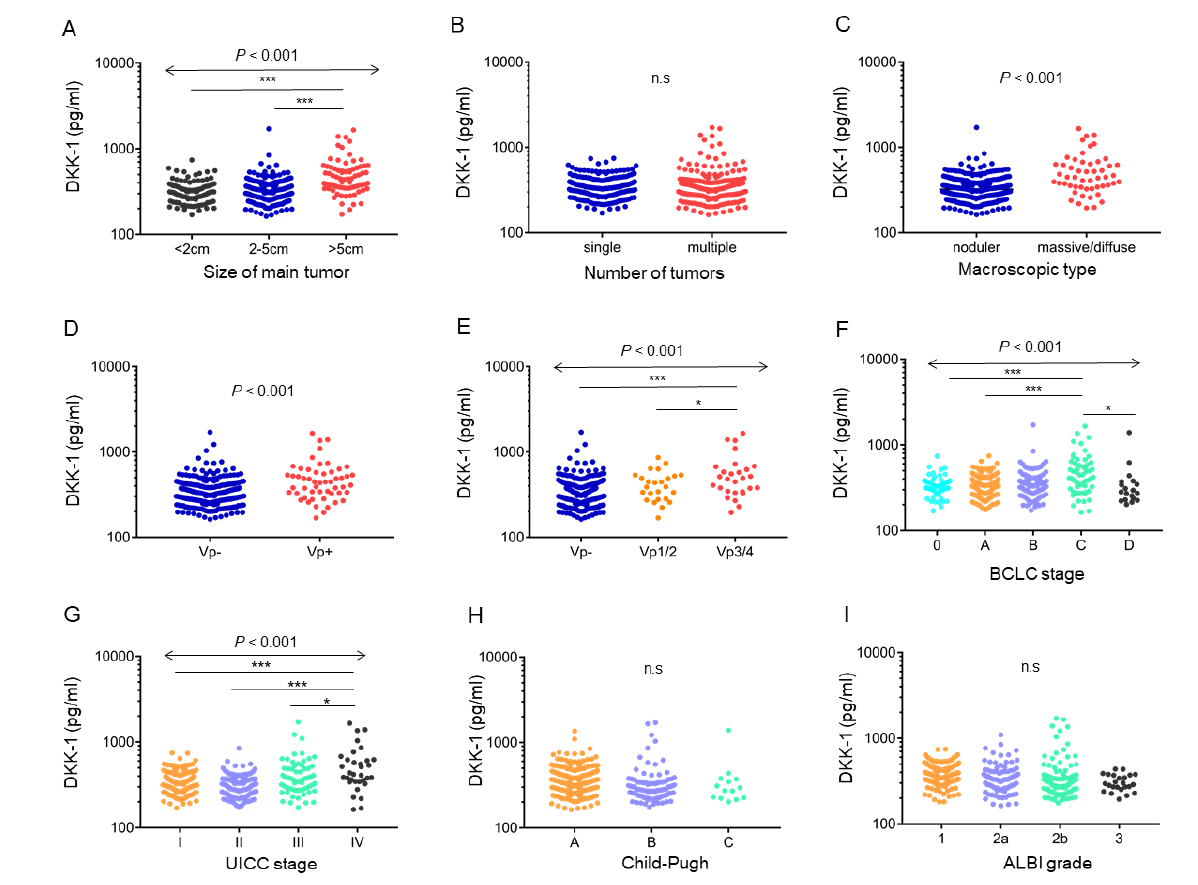
Figure 3. Relationship between serum Dickkopf-1 (DKK-1) levels and clinicopathological characteristics of hepatocellular carcinoma (HCC) and liver function. ( A ) Serum DKK-1 levels were elevated according to HCC size ( p < 0.001). ( B ) No difference was observed between solitary and multinodular HCC cases. ( C ) Serum DKK-1 levels were higher in the massive/diffuse type than in the nodular type, according to Eggel’s classification. ( D , E ) Serum DKK-1 levels were elevated in portal vein invasion (Vp)-positive patients compared with that in Vp-negative patients ( p < 0.001; D ). Serum DKK-1 levels were elevated in Vp3/4 patients compared with those in Vp- or Vp1/2 patients (*** p < 0.001 and * p < 0.05; E ). ( F , G ) Serum DKK-1 levels were significantly higher in advanced-stage patients classified according to the BCLC ( F ) and UICC stages ( G ). ( H , I ) Serum DKK-1 levels were not related to hepatic reserve assessed by using the Child – Pugh score ( H ) and albumin-bilirubin (ALBI) grade ( I ).